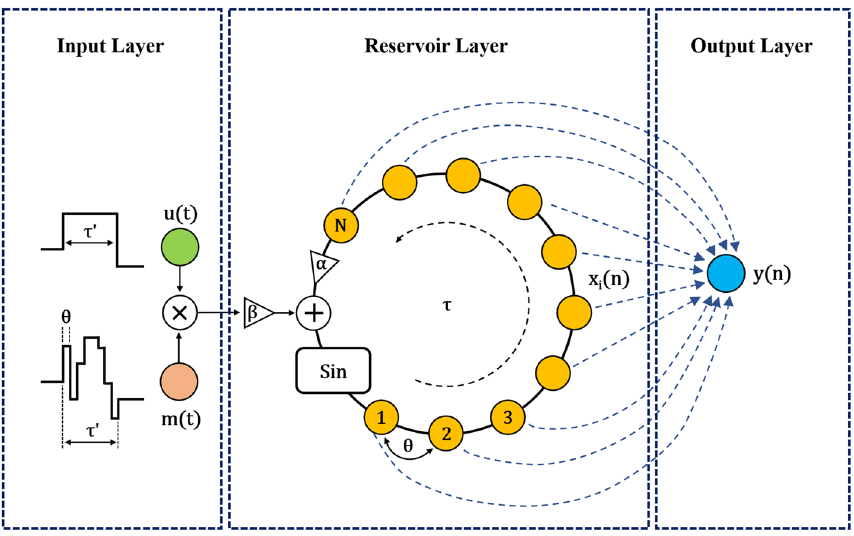
Figure 1. A schematic representation of a photonic TDR topology. A total of N virtual nodes are connected in a closed-loop ring architecture. The input signals are projected to the reservoir via a mask function while a gain β is set for the coupling strength. The nonlinear node, Sin, provides a sinusoidal function with an internal loop signal amplification factor (gain) α